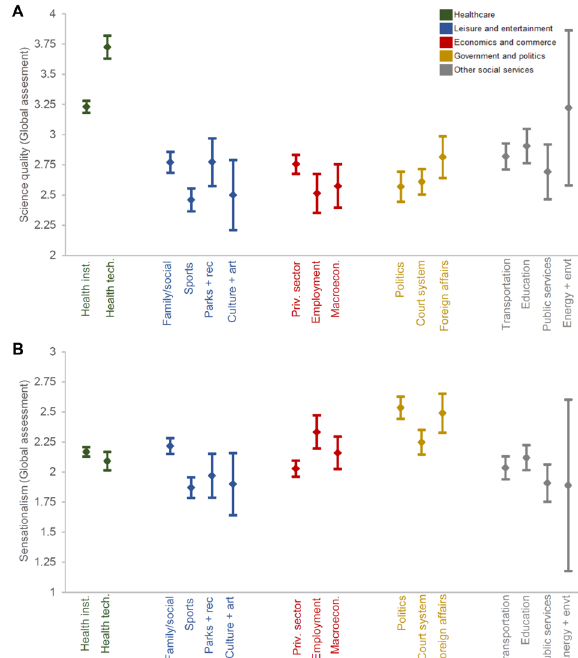
Fig. 6 Scienti fi c quality and sensationalism across COVID-19 news